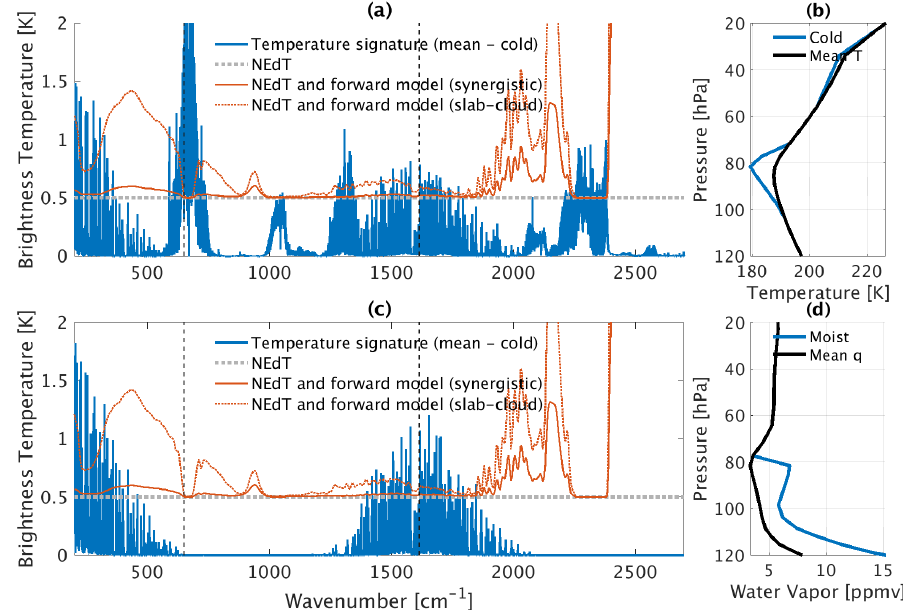
Figure 4. Spectral signals of above-storm atmospheric variations in (a) temperature and (c) water vapor from 200 to 2500cm − 1 . The signals are obtained by differencing the upwelling radiance spectra at the TOA simulated from the mean of all profiles (black curves in panels b and d ) and radiance spectra simulated from the mean of the profiles with overshooting convective clouds near the cyclone center (blue curves in panels b and d ). These signals are shown at a spectral resolution of 0.1cm − 1 . In (a) and (c) , the dotted light gray lines denote a NEdT of 0.5K (characterizing the AIRS instrument at cold scene temperature). The solid red lines denote the uncertainties for a combination of the NEdT and ε synergistic and the dotted red lines denote those for a combination of the NEdT and ε slab , which are convoluted at 5cm − 1 spectral intervals in this plot. The AIRS spectral range used in this study is 649.6–1613.9cm − 1 and is marked by dashed dark gray